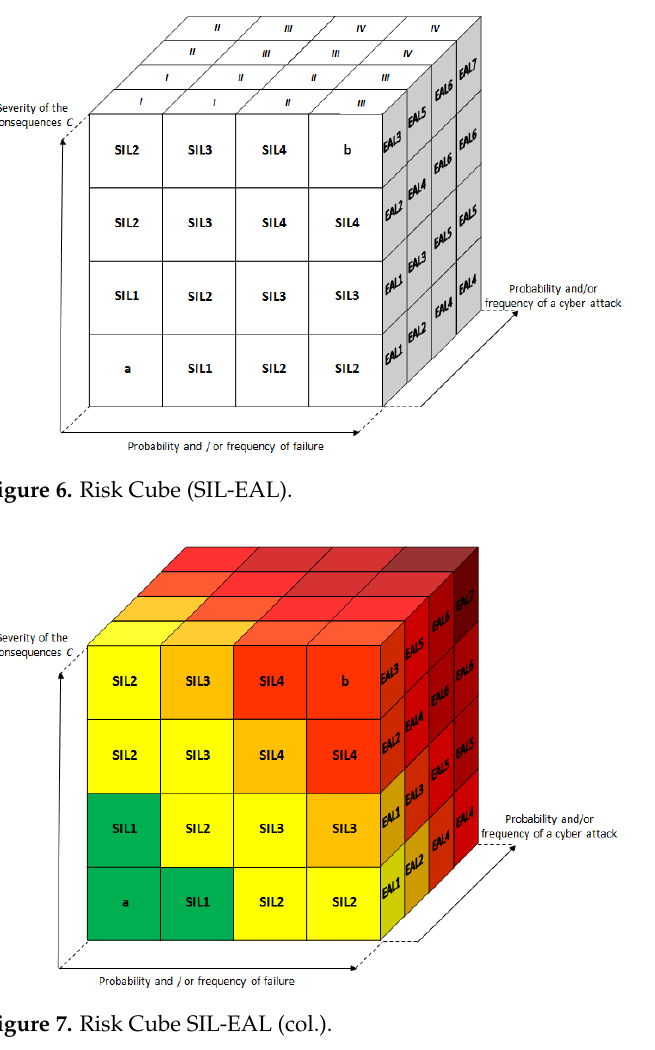
Figure 5. Risk Cube SIL-SAL (col.).